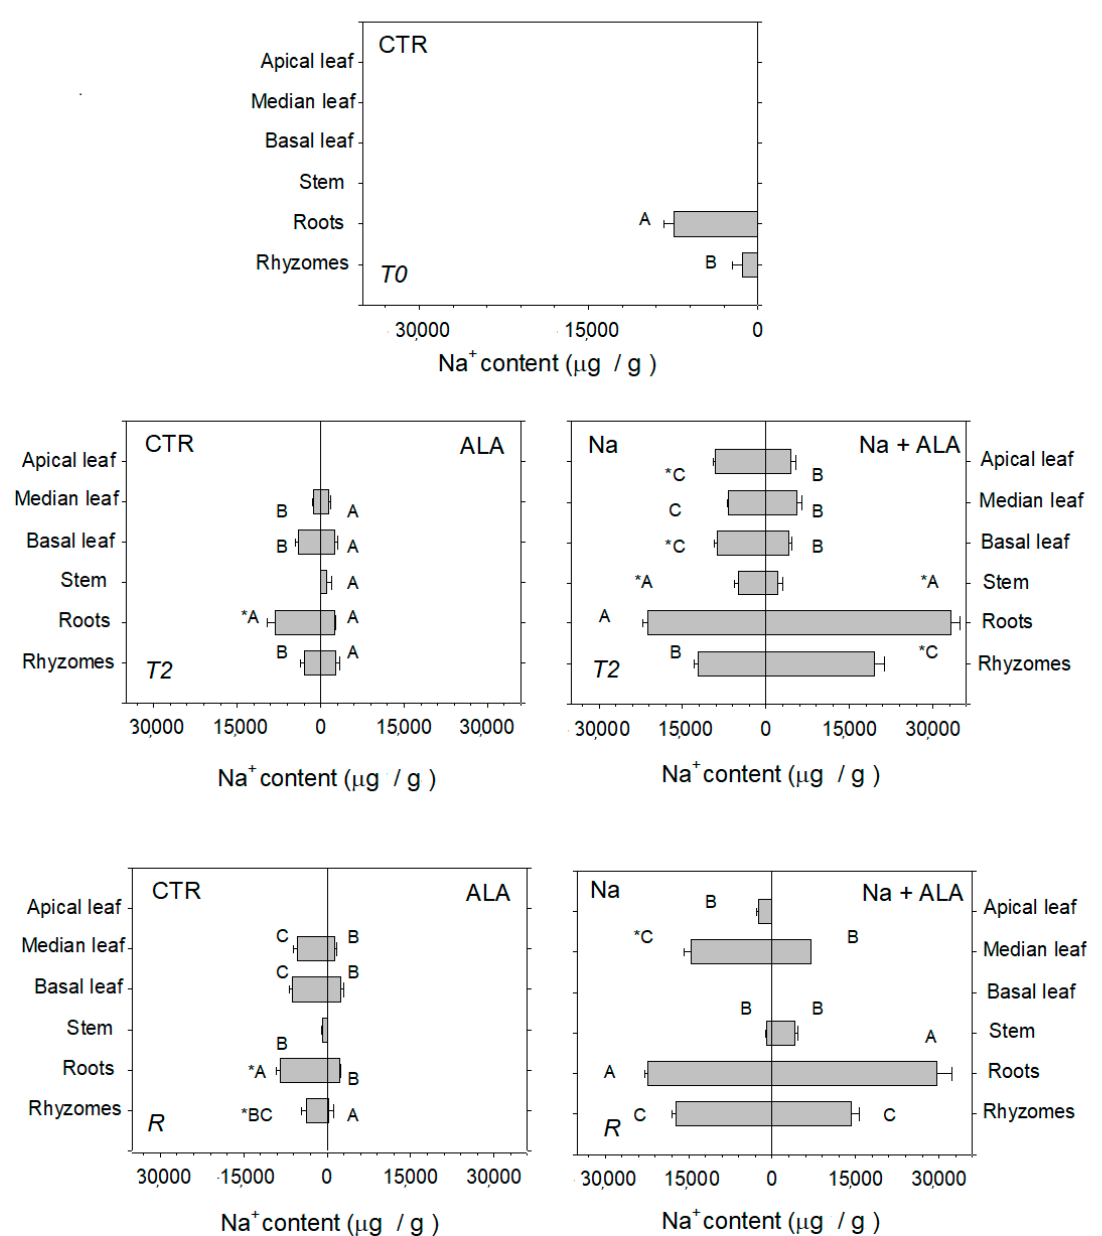
Figure 1. Concentration of Na + ( μ g/g) measured at different time points (T0, T2, and R) in apical, median, and basal leaves, as well as in stems, roots, and rhizomes of Arundo donax controls (CTR), salt-stressed (Na), ALA-treated (ALA), and both salt-stressed and ALA-treated (Na + ALA) plants. Mean values ± SE are shown. Uppercase letters indicate statistically significant differences between (apical, median, and basal) leaves, roots, and the rhizome along the profile of plants undergoing the same treatment; asterisks indicate statistically significant differences between the (apical, median, and basal) leaves, roots, and rhizome of plants undergoing different treatments ( p < 0.05; n = 3). More details about the statistically significant differences between treatments are shown in Table S1.